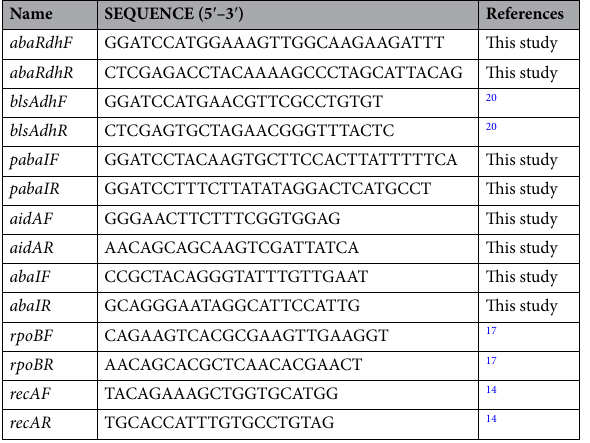
Table 3. Primers used in this